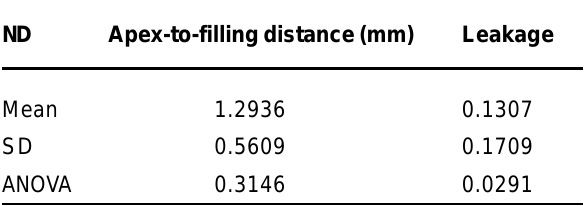
TABLE 4- Statistical data for the non-disrupted (ND) group